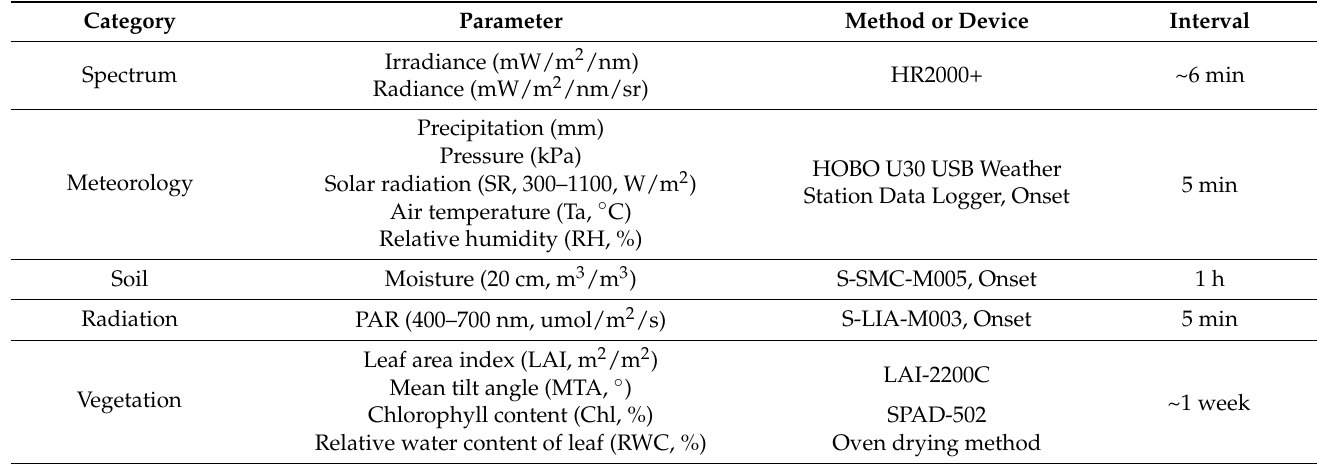
Table 2. Parameters of winter wheat measurements at Fangshan Comprehensive Experimental Station in 2017 in Beijing,